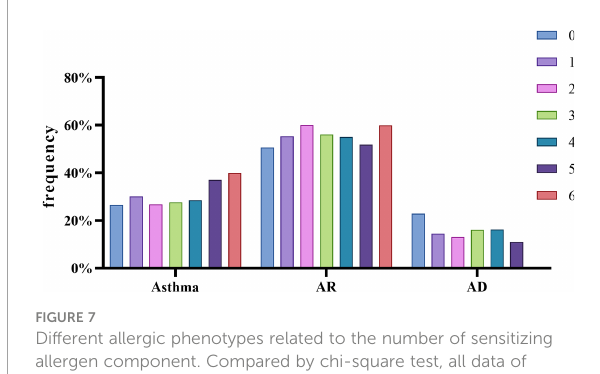
FIGURE 7 Different allergic phenotypes related to the number of